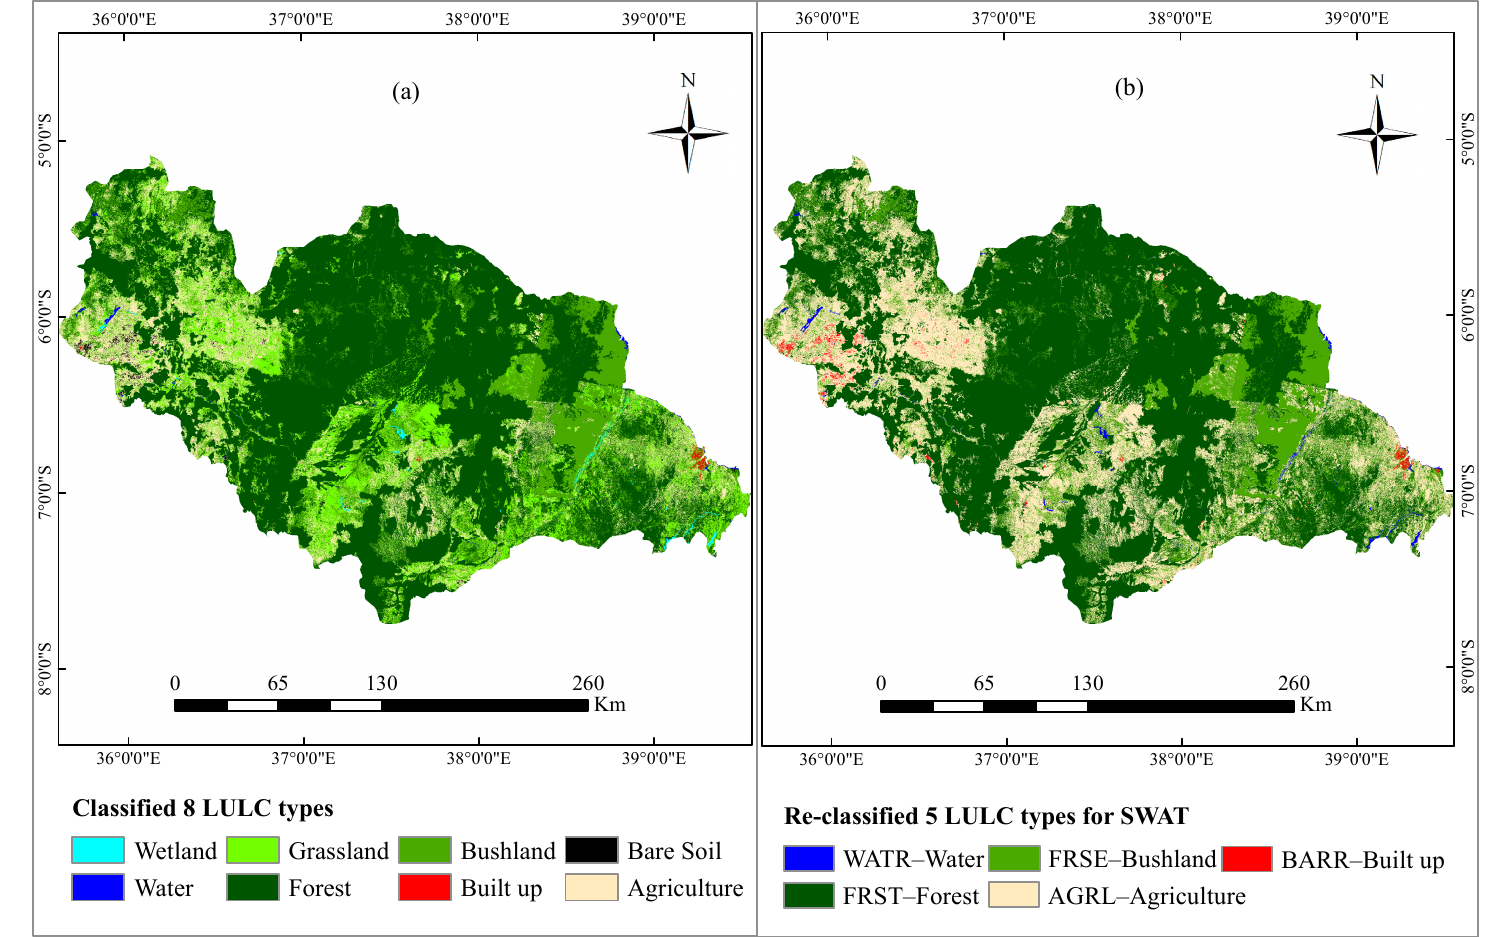
Figure 3. The LULC data of the WRB used for the SWAT model: ( a ) Classification according to the ANN technique; ( b ) Reclassified based on the SWAT land-use database.